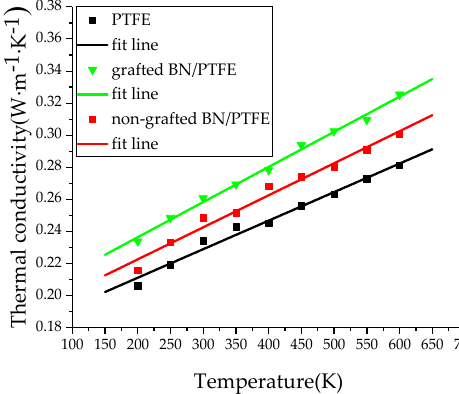
Figure 10. Thermal conductivity versus temperature for three models.